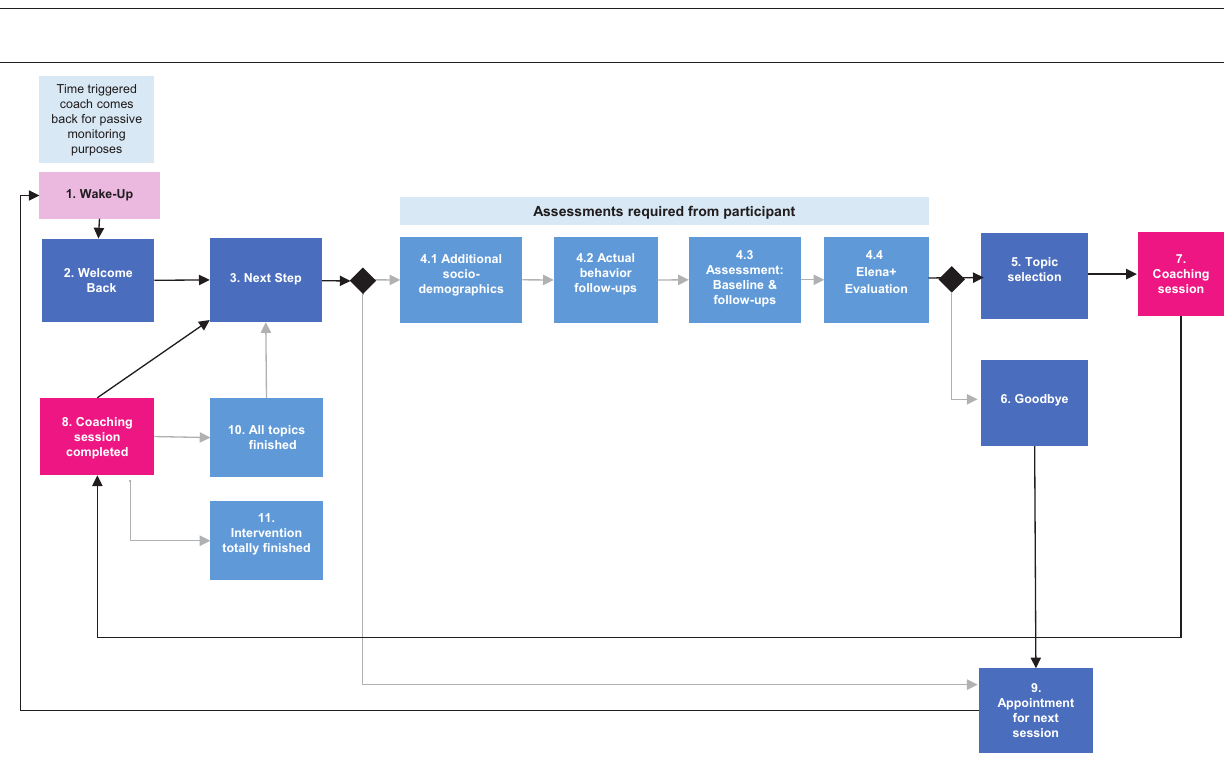
FIGURE 2 | First use of Elena + . ASI, Agenda Setting Input.